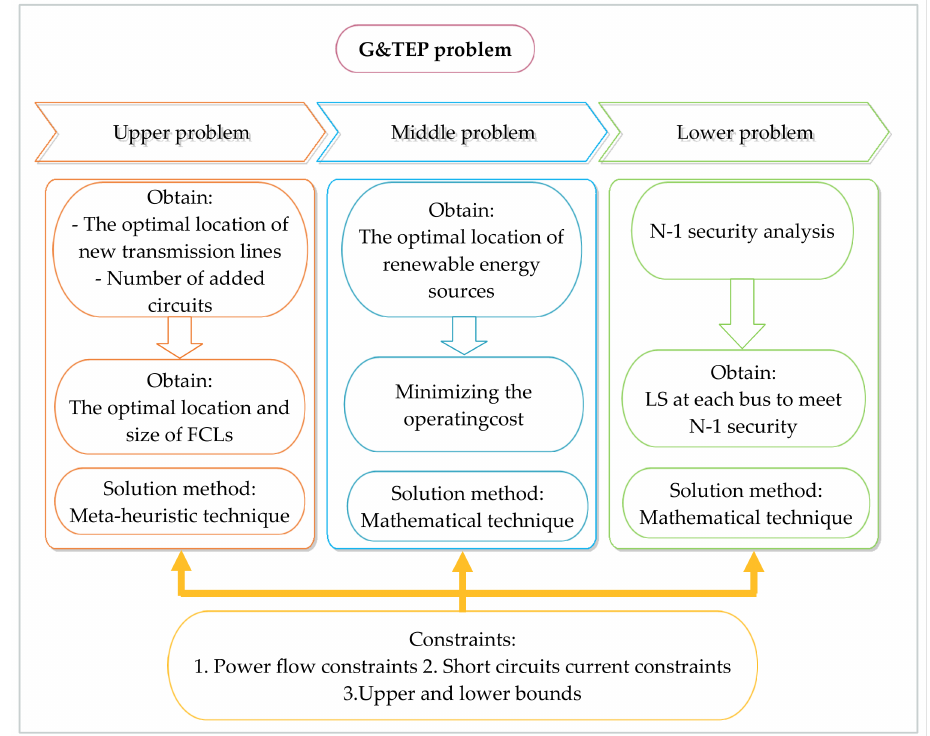
Figure 2. Suggested model to solve the G&TEP